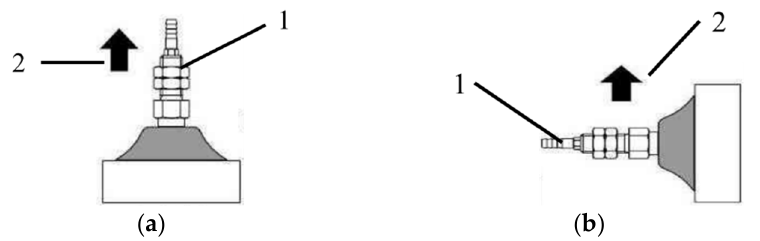
Figure 16. Two suction modes of suction cups: ( a ) horizontal suction; ( b ) vertical suction, where 1: suction cups; 2: direction of suction cup movement.